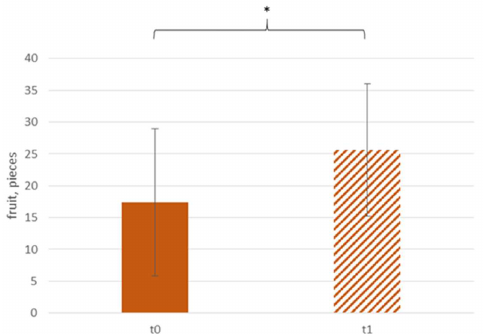
Figure 4. Daily sale of fruit according to time; * p < 0.05.